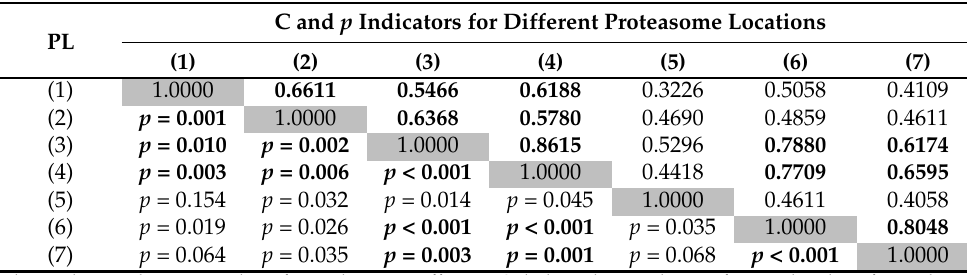
Table 5. Correlation of proteasome ChTL activity in tumor and different intestine